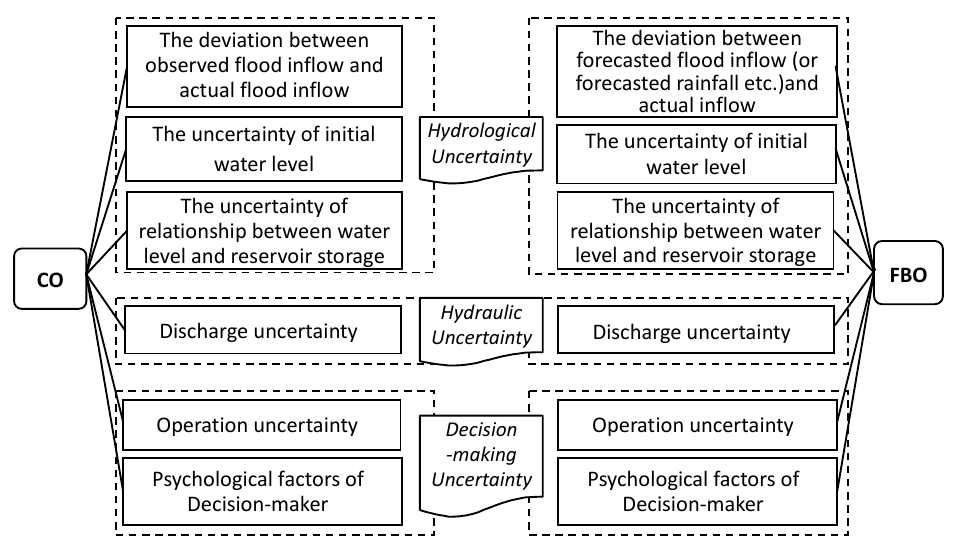
Figure 1. The potential risk factors for two flood regulation modes.